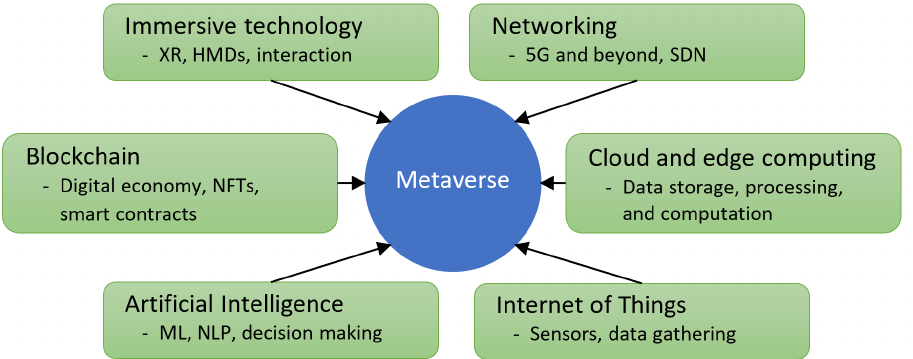
Figure 1. Key technologies required to empower the Metaverse.